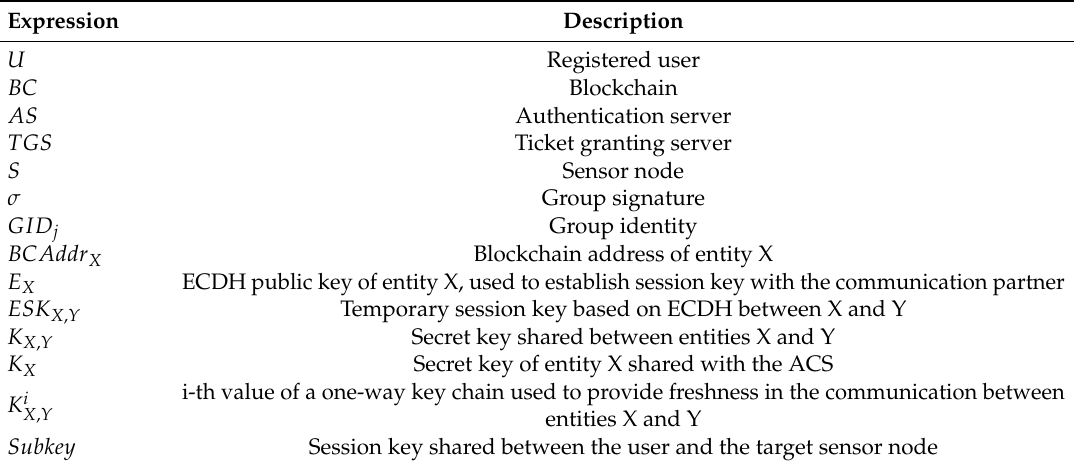
Figure 6. The enhanced Hidra architecture and message exchanges. Table 3. Terminology and Notation Table 4. Details of the content of enhanced Hidra messages.